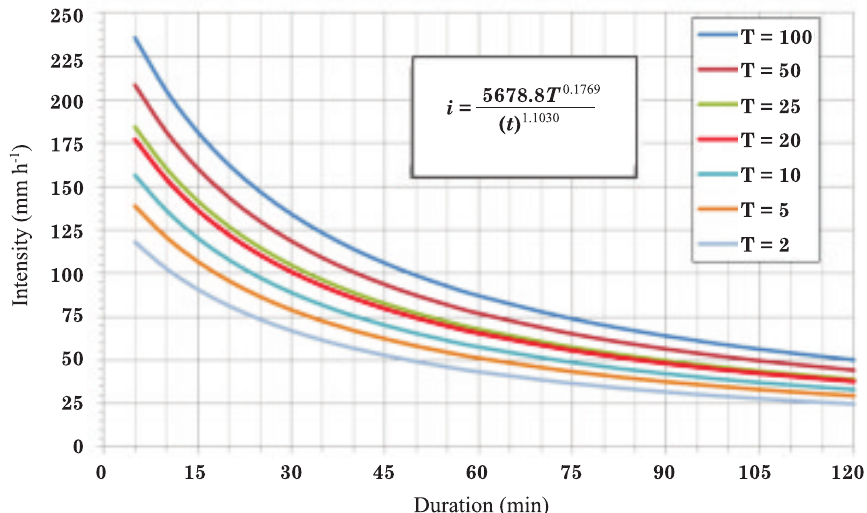
Figure 2. Equations of heavy rainfall events for durations up to 120 min, adjusted to Urussanga, Santa Catarina.